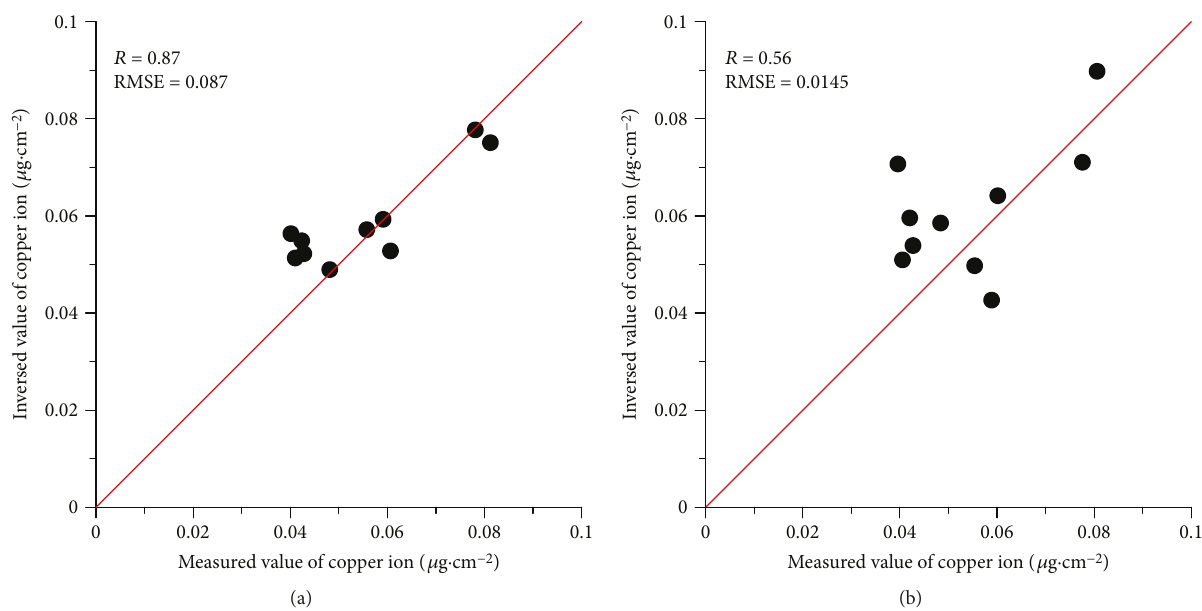
Figure 13: Comparison between measured and inverted values of copper ion content. (a) The fi nal inversion results of copper ion content. (b) The inversion result of copper ion content after the fi rst inversion